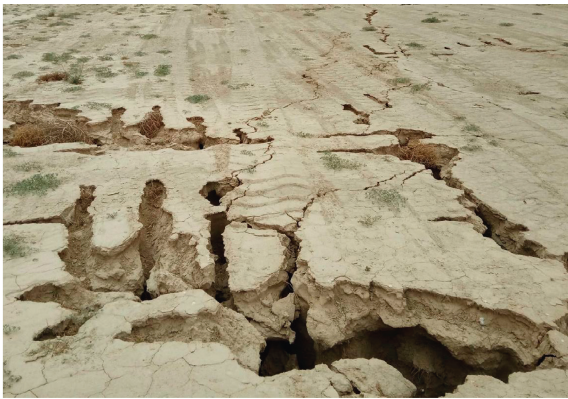
Figure 1: Loess is eroded by water.